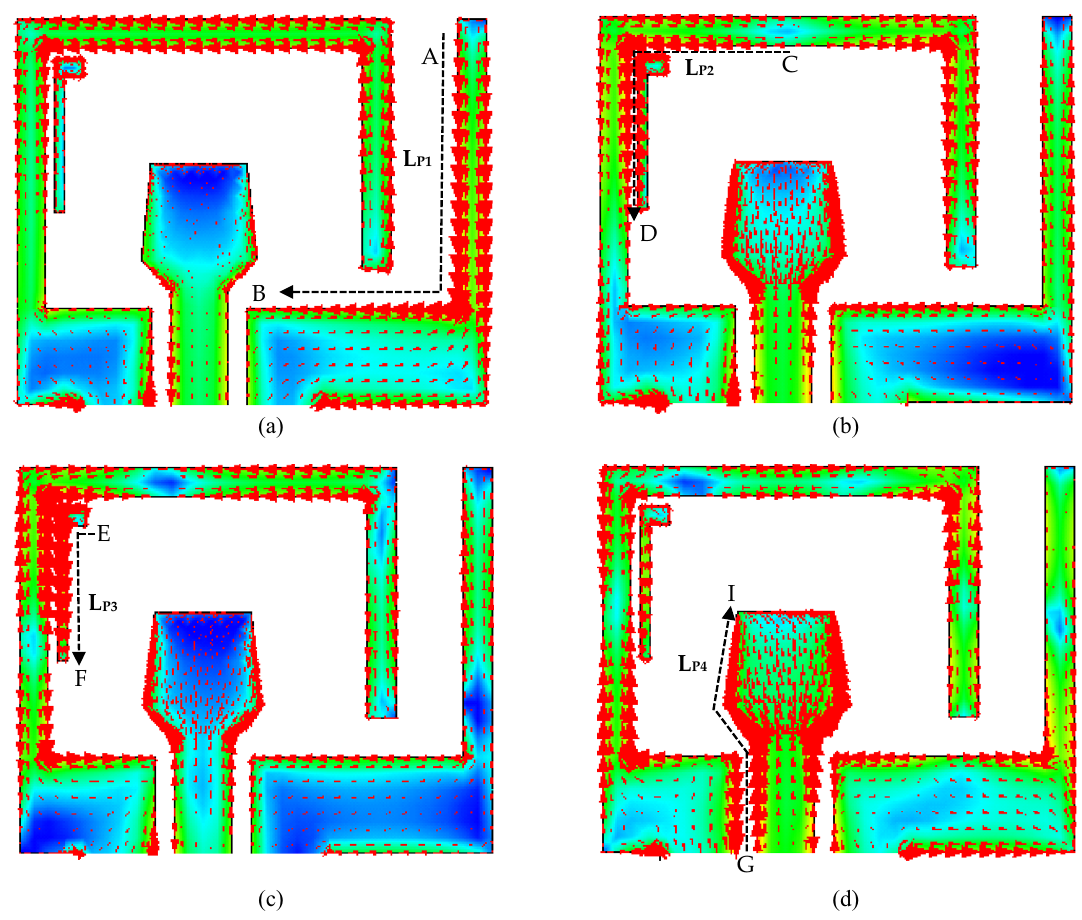
Figure 5. Current distributions at ( a ) 3.375, ( b ) 5.90, ( c ) 7.98, and ( d ) 10.1